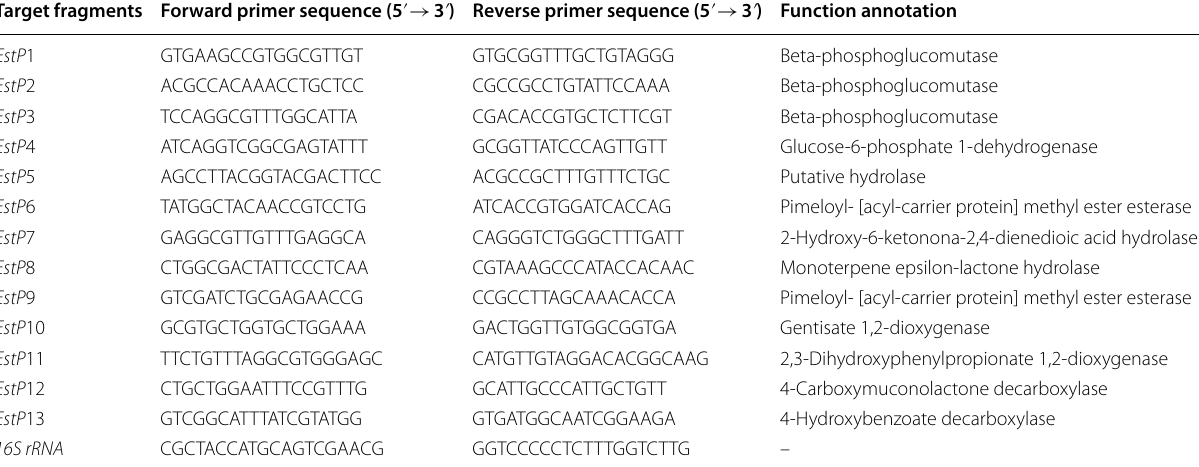
Table 1 Primers for amplification of predicted and 16S rRNA genes